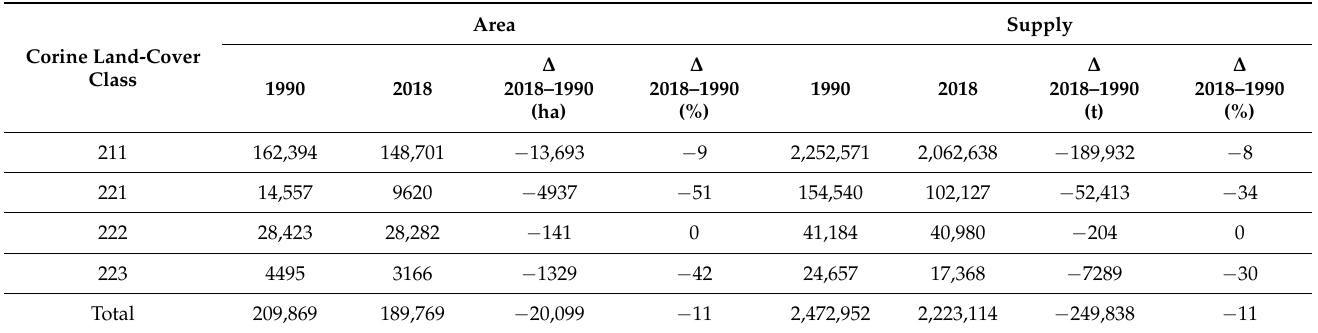
Table 2. Agricultural areas (expressed in hectares and percentage) and related agricultural production (expressed in tons and percentage) changes between 1990 and